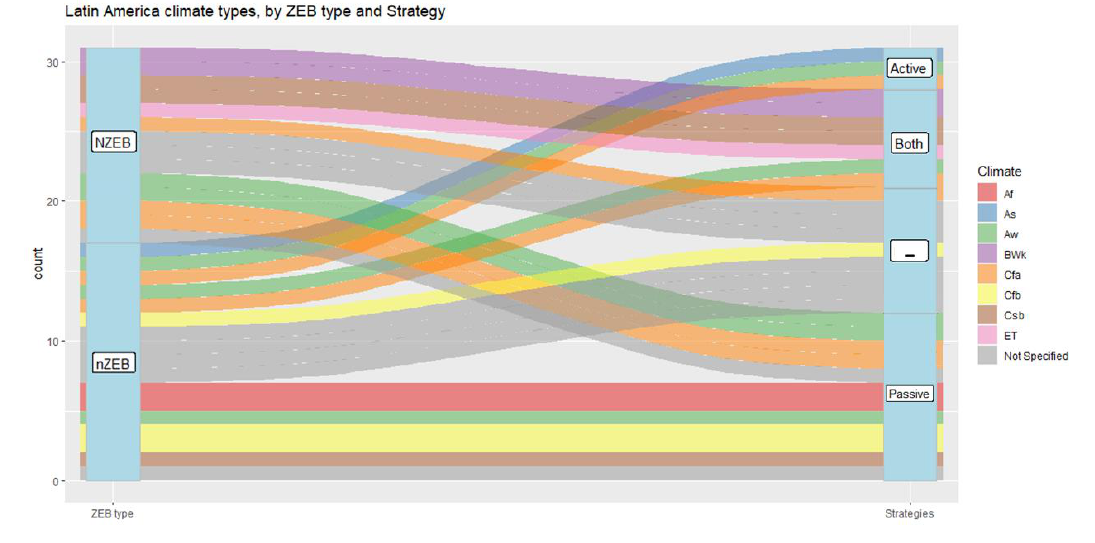
Figure 7. ZEB types arranged by climate type and strategy. Table 2. Countries in Latin America Energy generation.